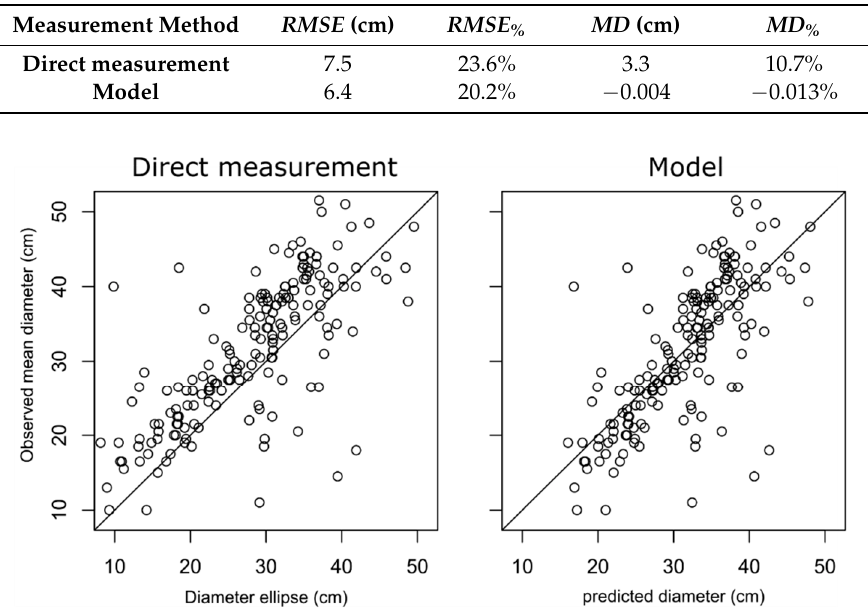
Table 4. Summary of the accuracy assessment of the measurement of the mean diameter using either the direct measurement approach or the modelling approach. The results are reported for RMSE , MD , and their respective values as percentage of the mean observed mean diameter ( RMSE % , MD % ).